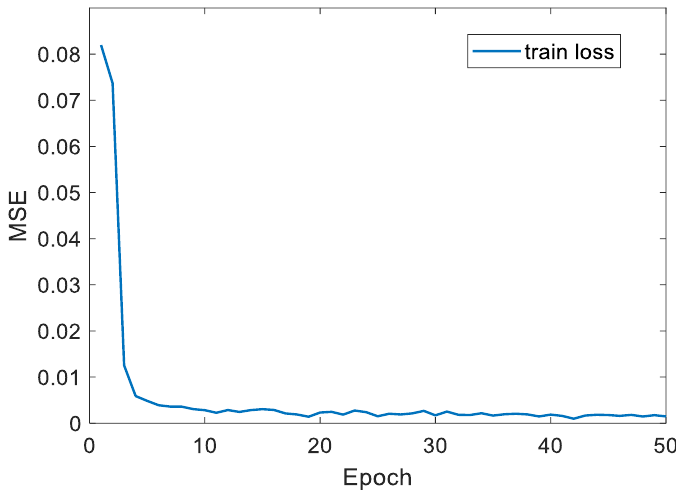
Figure 10. Network model training loss graph.